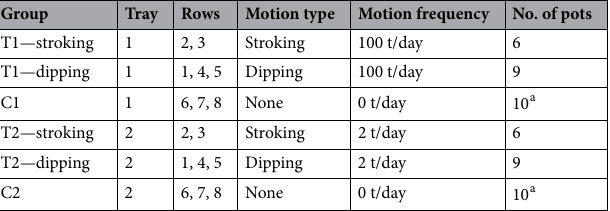
Table 1. Description of four treatment groups (T) and two control groups (C) for Experiment 1. consisted of four pots, while rows 1–7 consisted of three pots